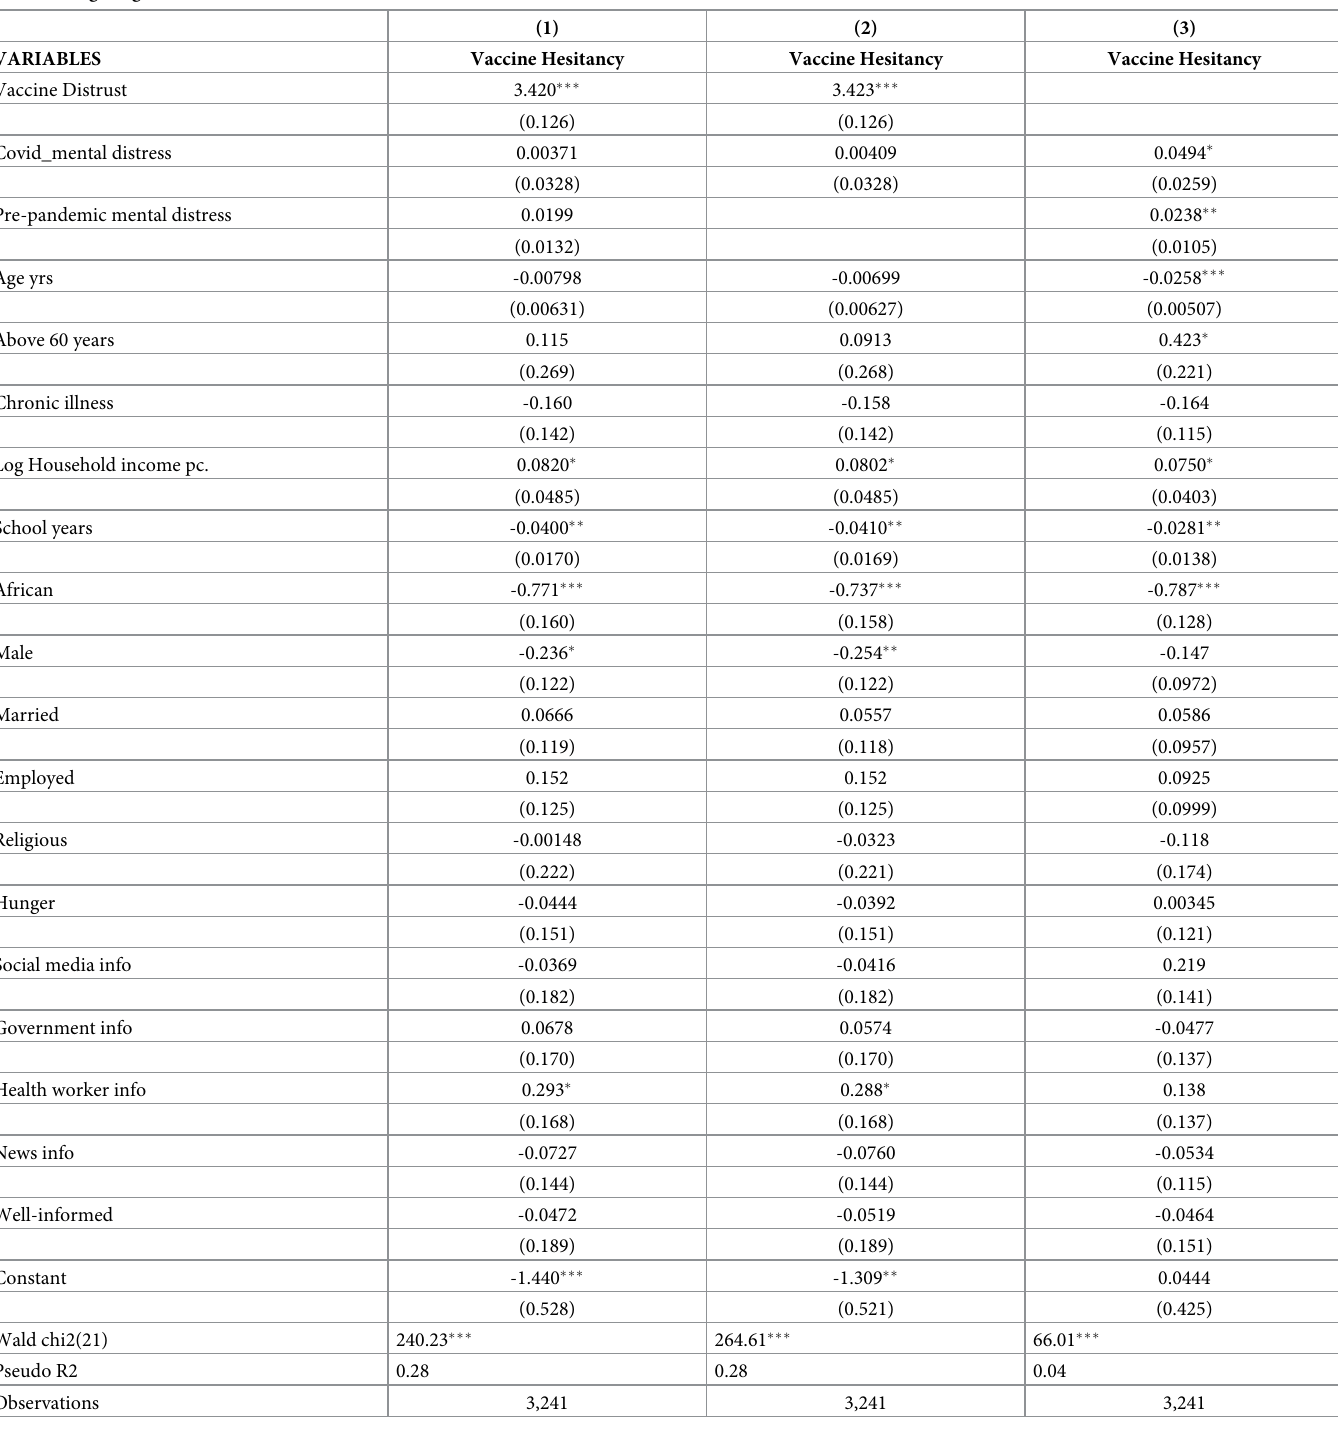
Table 2. Logit regression